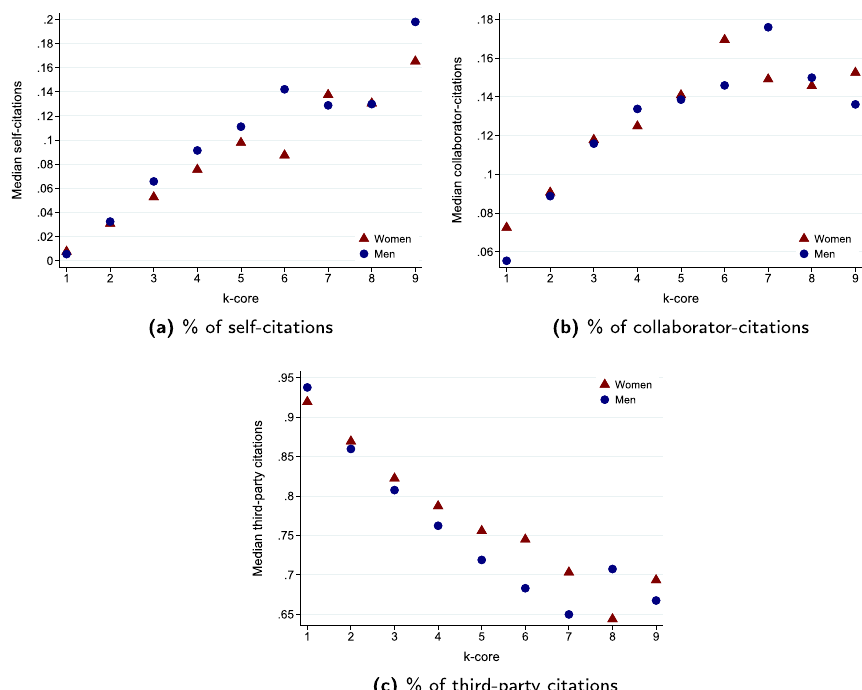
Fig. 4 Type of citations according to k ‑max and gender: median. Notes : we plot until k = 9 since it is the last k that contains at least two observations per